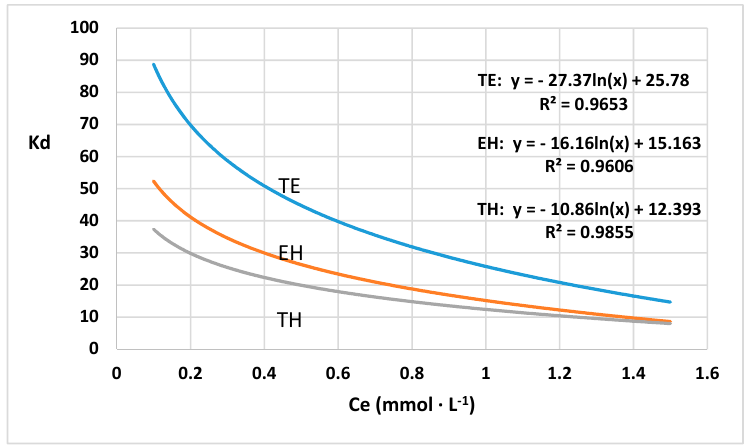
Figure 5. Percentage of the total amount of W adsorbed (TW ads ) at increasing ionic strengths for the three investigated soils.